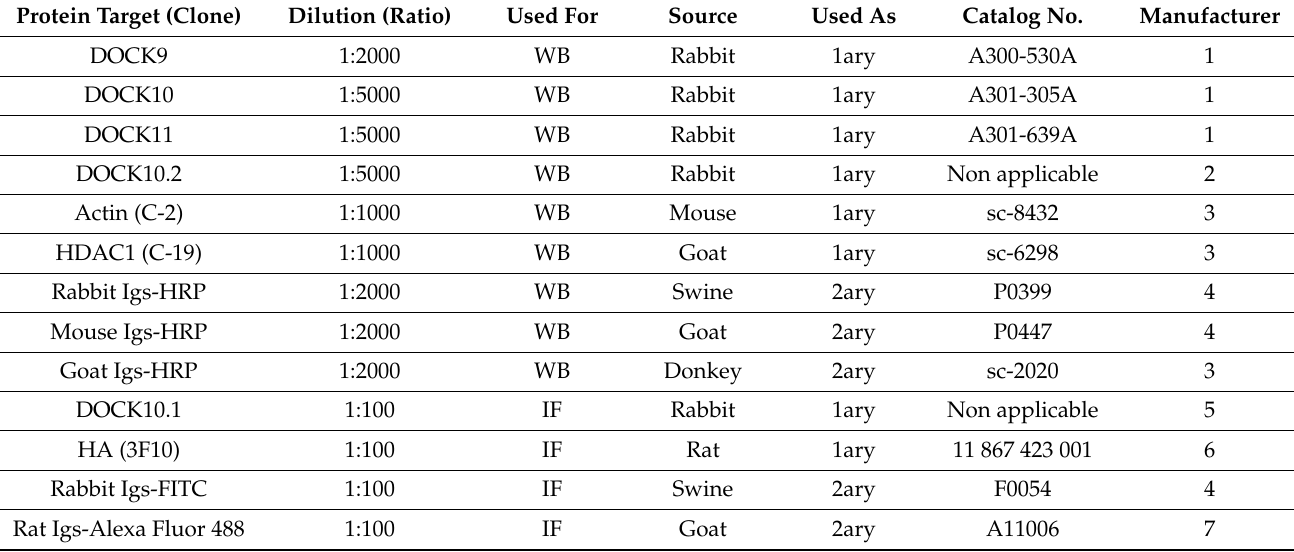
Table 2. Antibodies used in this